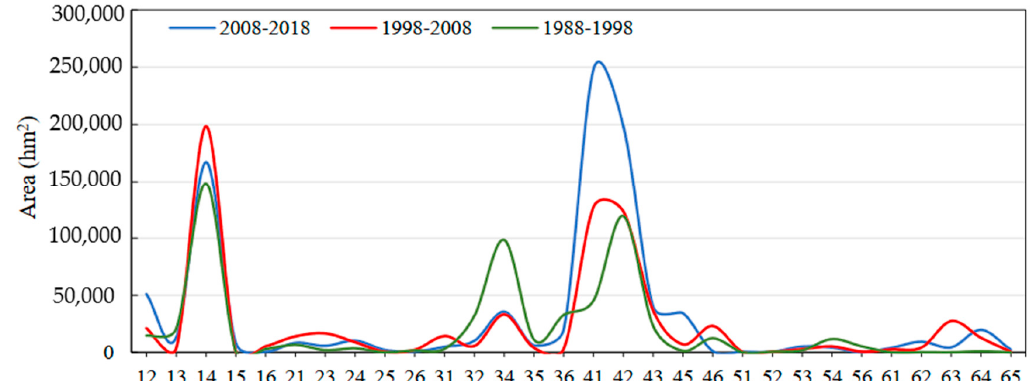
Figure 5. Changes in land-use types in the PLEEZ from 1988 to 2018. Note: Nos. 1–6 represent forestland, construction land, water area, cultivated land, grassland, and unused land, respectively. Code 12 represents forestland converted to construction land, and the other codes follow the same rule.